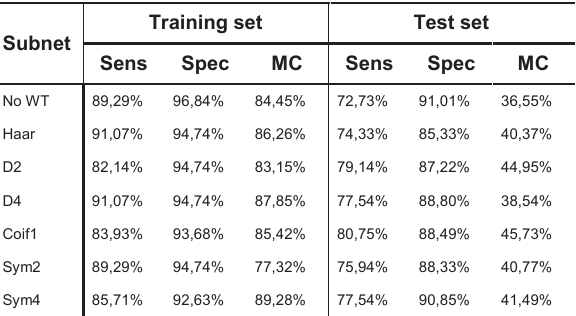
training set: Sensitivity (Sens), Specificity (Spec) and group of columns represents the same